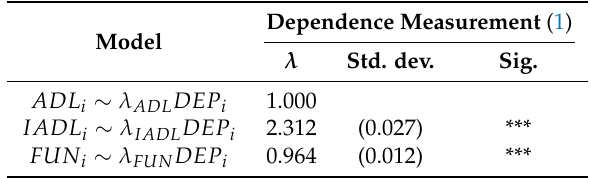
Table 6. Results for the measurement of dependence (model 1).